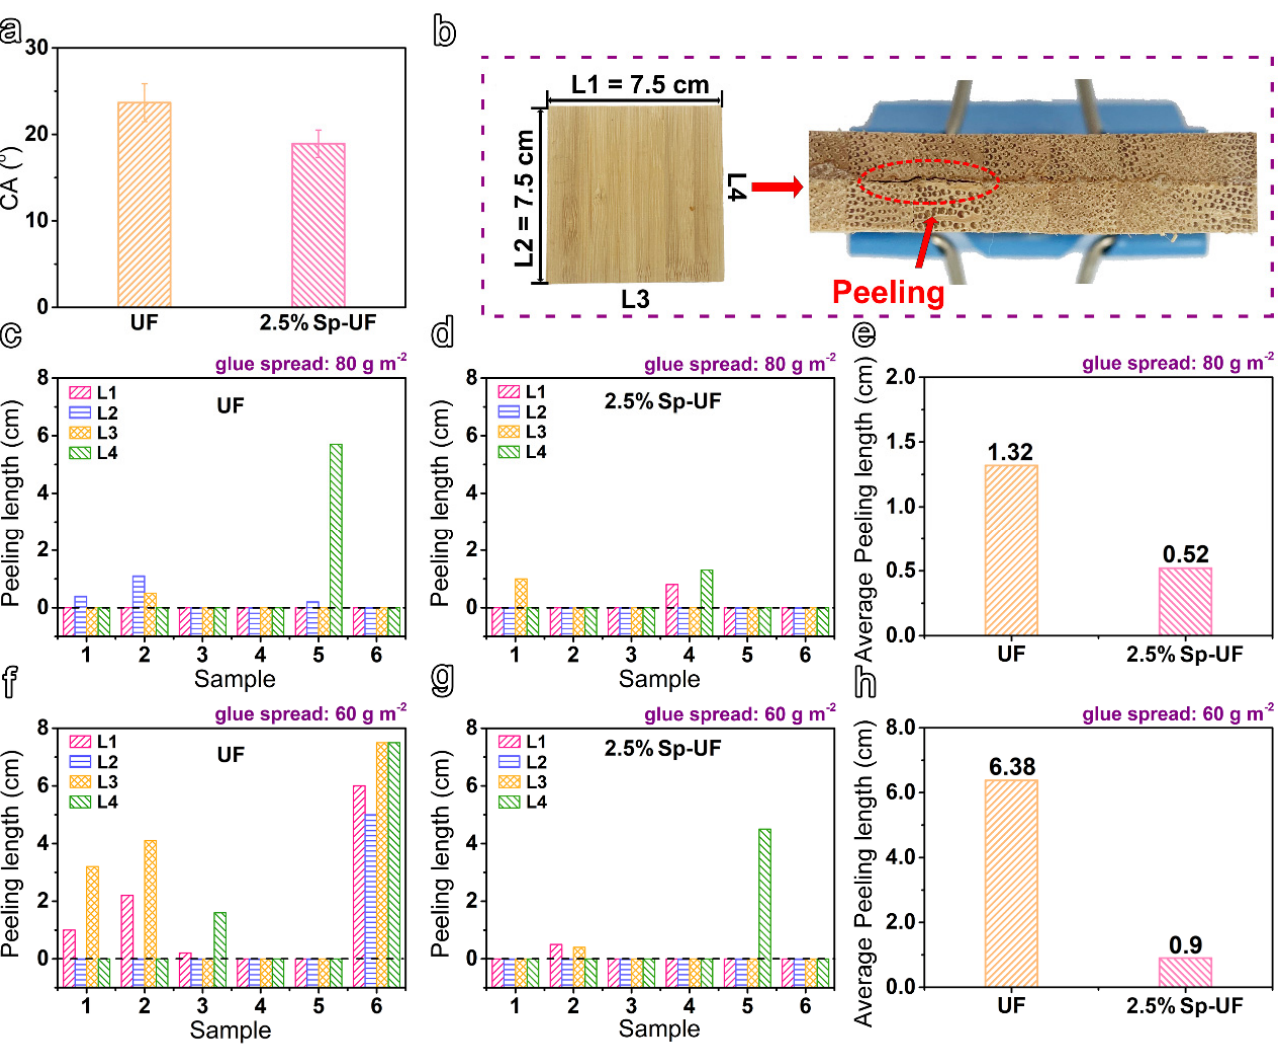
Figure 7. ( a ) The CA values curve of UF and 2.5% Sp-UF resins on the bamboo veneer surface, ( b ) Optical photos of the laminated bamboo veneer and its peeling of the glue line, ( c , d ) Peeling length graphs of UF and 2.5% Sp-UF resins and ( e ) the comparison graph of their average peeling length at glue spread of 80 g m − 2 , ( f , g ) Peeling length graphs of UF and 2.5% Sp-UF resins and ( h ) the comparison graph of average peeling length at glue spread of 60 g m − 2 .